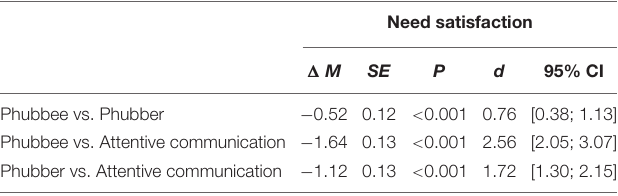
TABLE 1 | Phubbing effects on reported need satisfaction: multiple comparisons between experimental conditions.